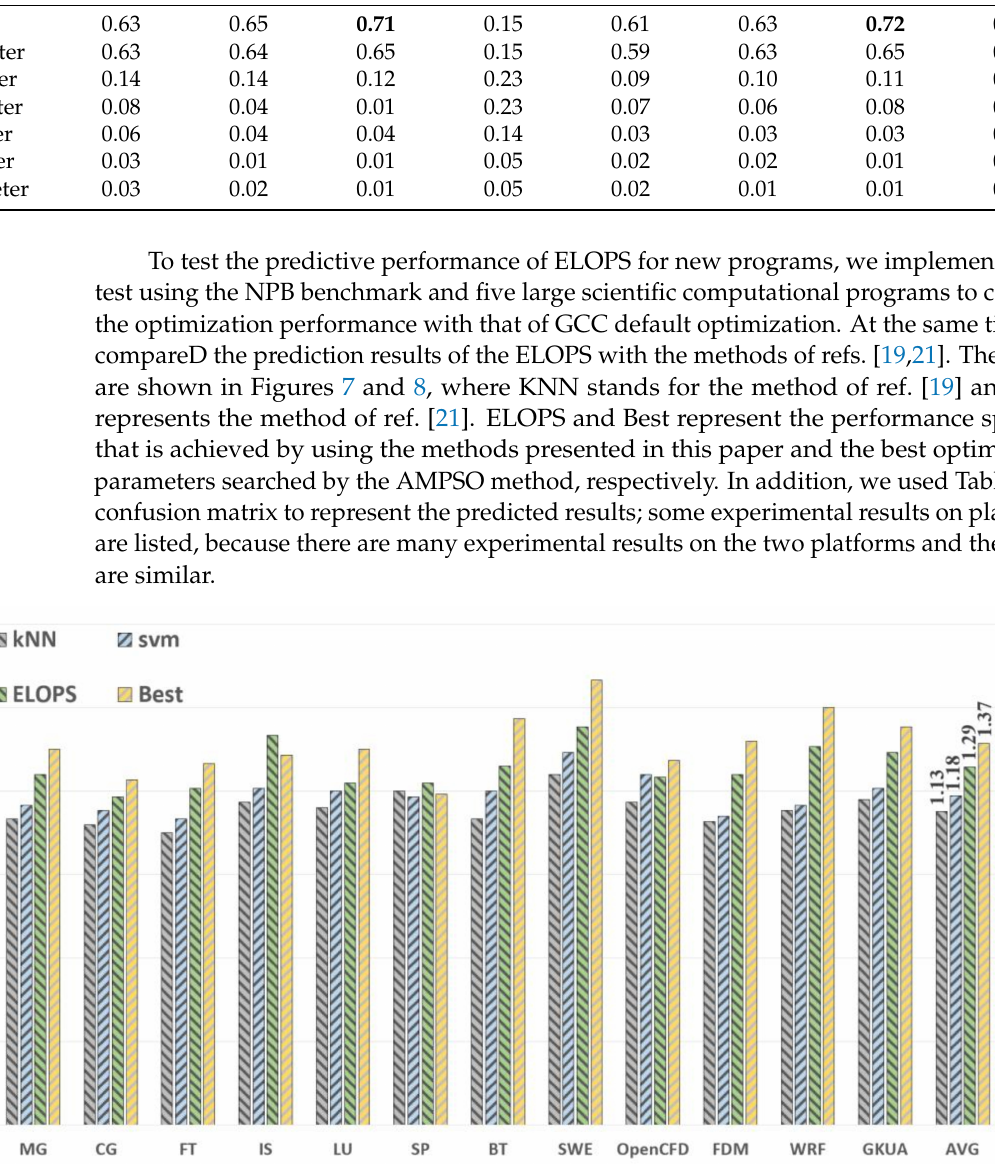
Figure 7. The speedup of the new programs when taking the ELOPS model on Platform